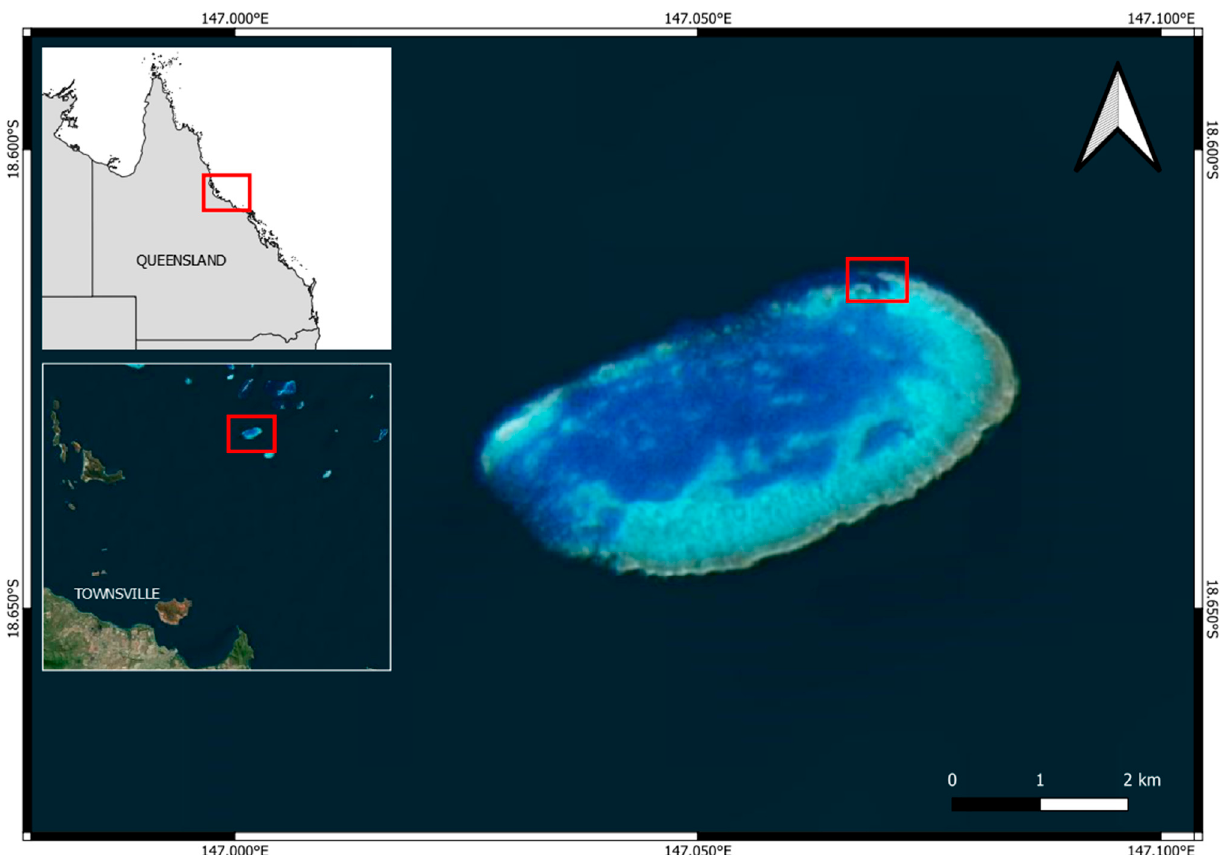
Figure 1. Map of John Brewer Reef in Townsville, Queensland, Australia. Coral Greenhouse installation location in red box.